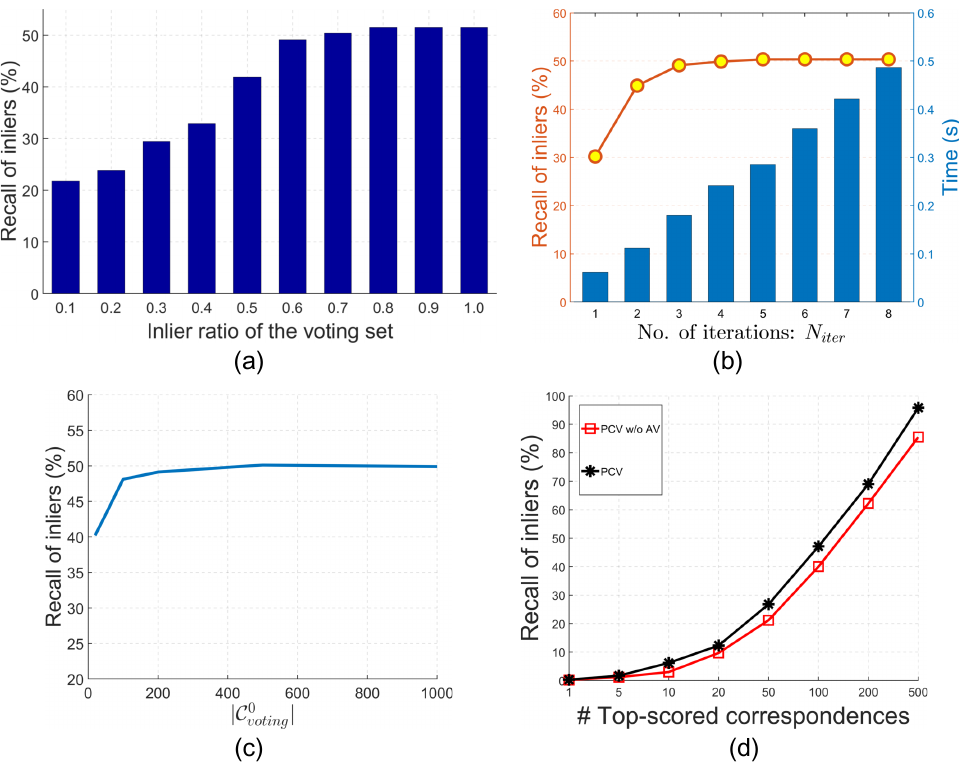
Figure 5. Experimental analysis for PCV. ( a ) The effect when using voting sets with different inlier ratios on the feature matching performance. ( b ) Parameter analysis for N iter . ( c ) Parameter analysis | . ( d ) The effectiveness of making the cardinality of the voting set κ (Equation (8)) for |C 0 voting